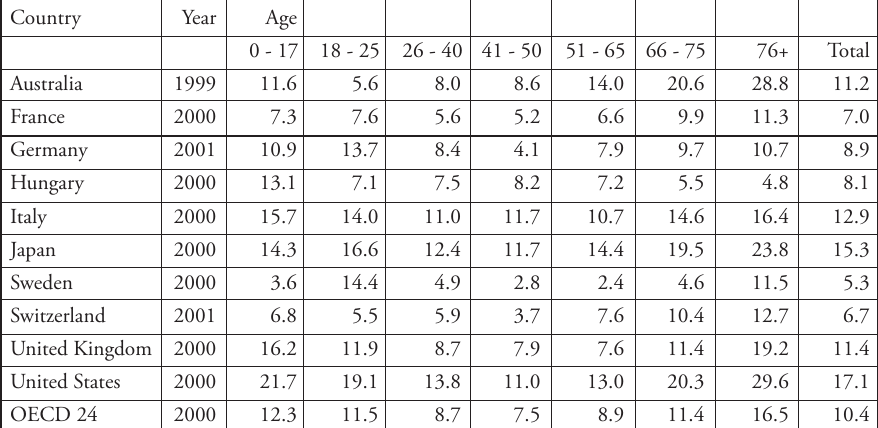
Table 4: Relative poverty rates by age groups, ca.